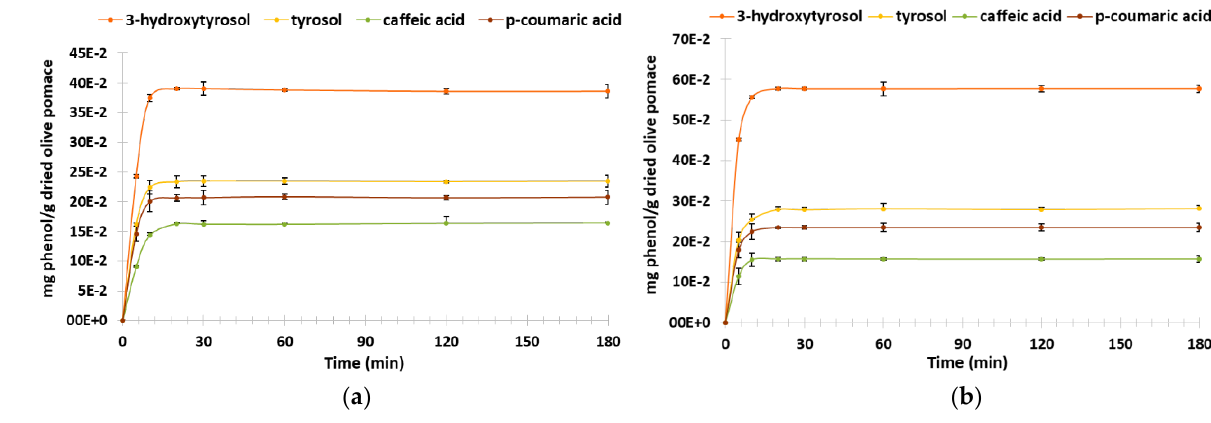
Figure 5. Kinetic of dried olive pomace extraction at 20 °C and at 50 °C: UPLC 20 °C ( a ), UPLC 50 °C ( b ).